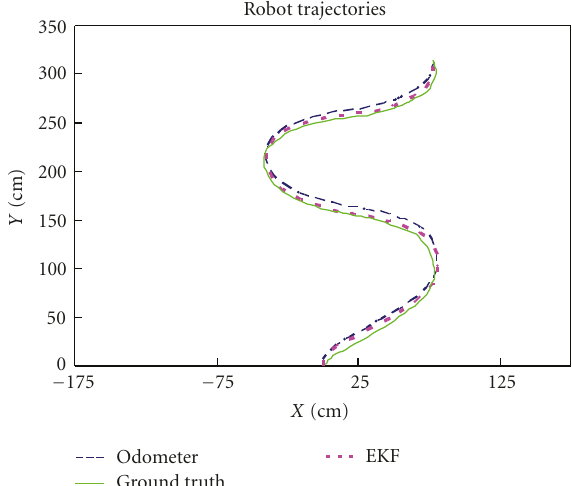
Figure 11: Trajectories of odometer, EKF, and ground truth.